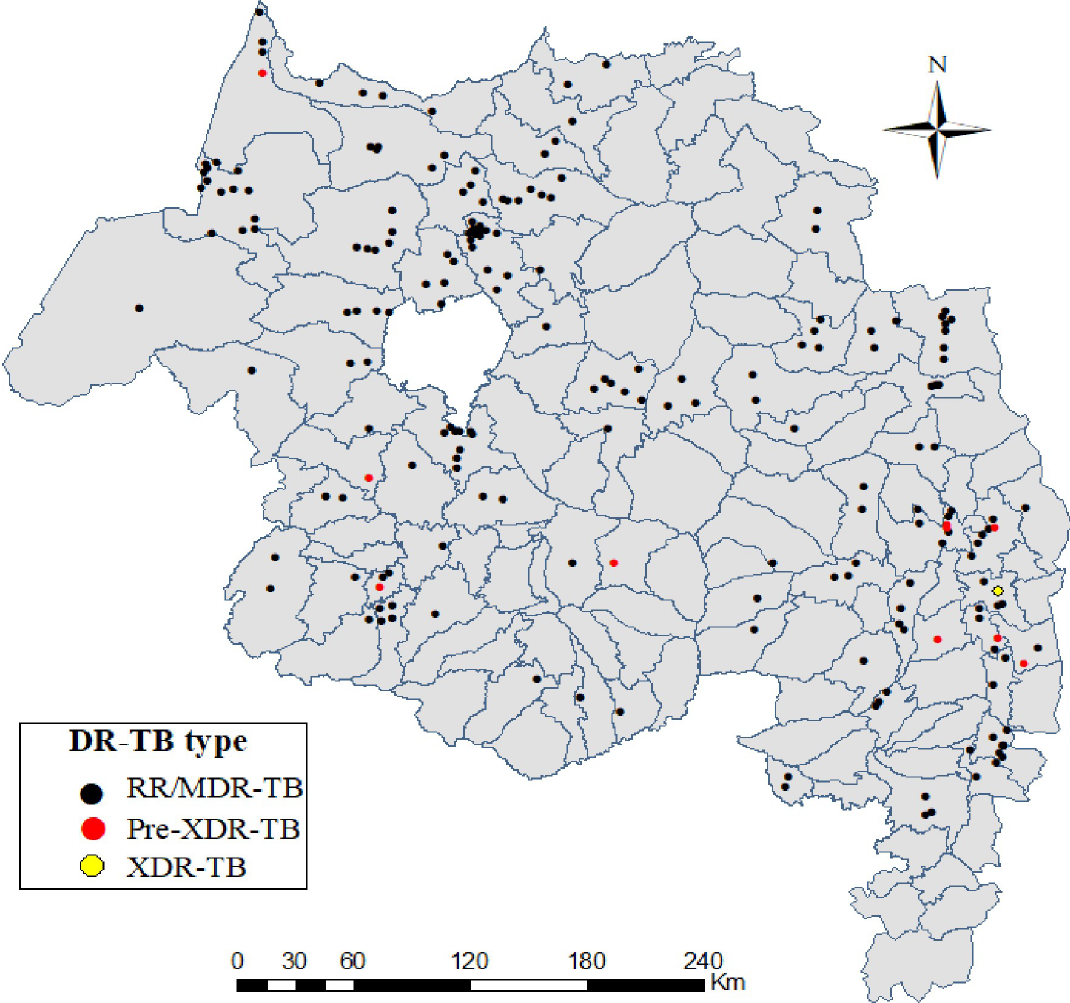
Fig 2. Distribution of drug resistant M . tuberculosis cases among the districts of Amhara region, Jan, 2016- Sept, 2018 (n = 209).